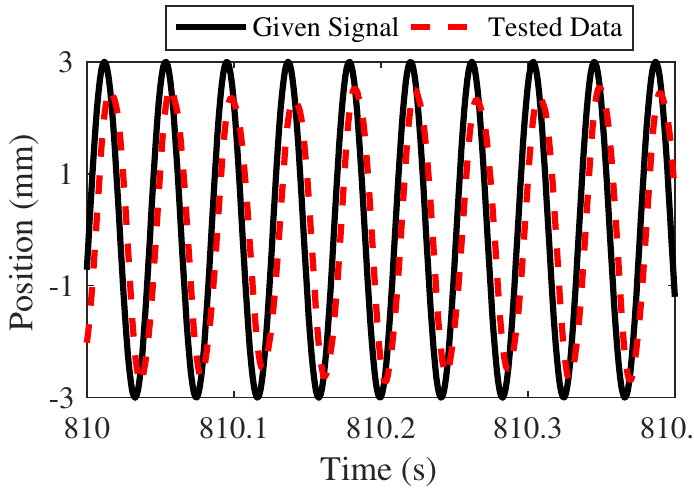
Figure 35. Position with